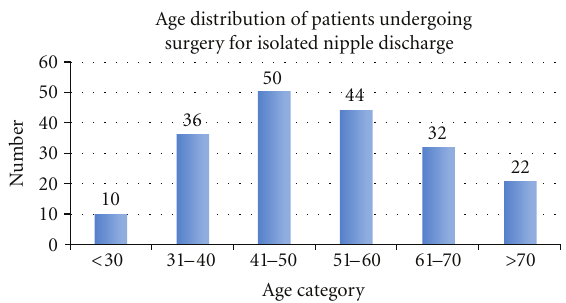
Figure 1: Age distribution of patients undergoing surgery for spontaneous isolated nipple discharge.